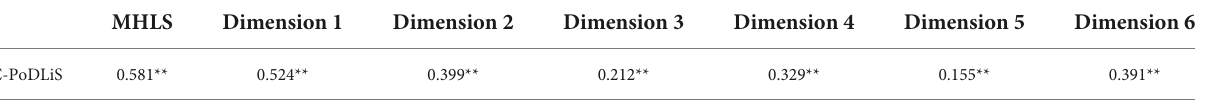
TABLE 5 Correlations of the C-PoDLiS and MHLS subscales.